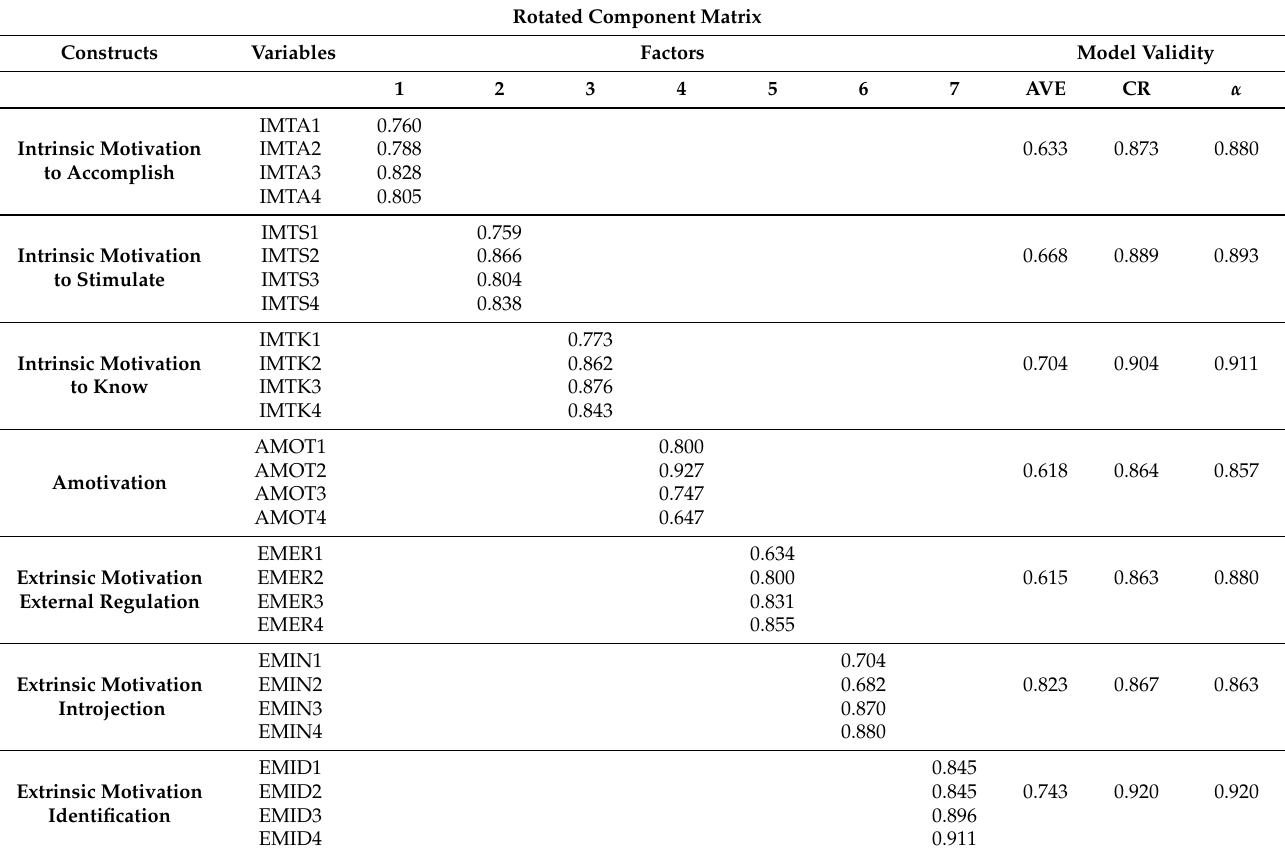
Table 3. Exploratory Factor Analysis of the MATAMS sample regarding Portuguese students.